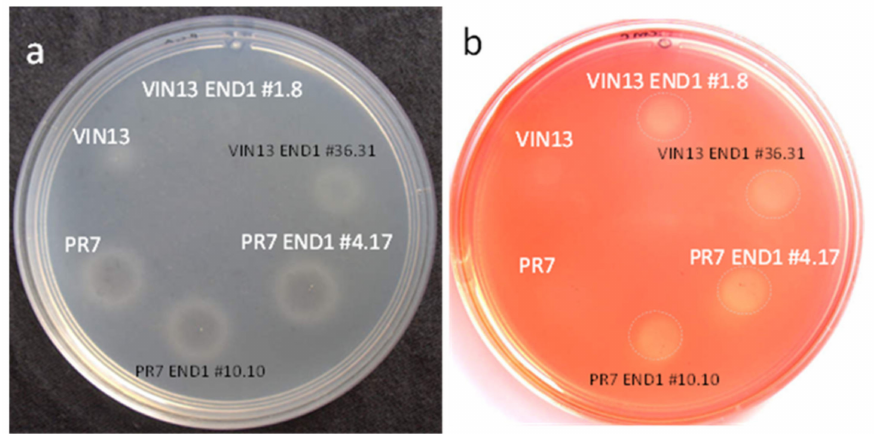
Figure 2. ( a ) Polygalacturonase activity (clear zones inside white rings) on a polygalacturonic acid agarose plate and ( b ) endo- β -1,4-glucanase activity (light yellow zones, circled in dashed lines) on a CMC agar plate with the yeast strains used in this study (VIN13, VIN13 END1 #1.8, PR7, PR7 END1 #4.7). Other strains that were also successfully integrated with the MPOF END1 cassette (VIN13 END1 #36.31 and PR7 END1 #10.10) are also shown here, but they were not used in the pomace